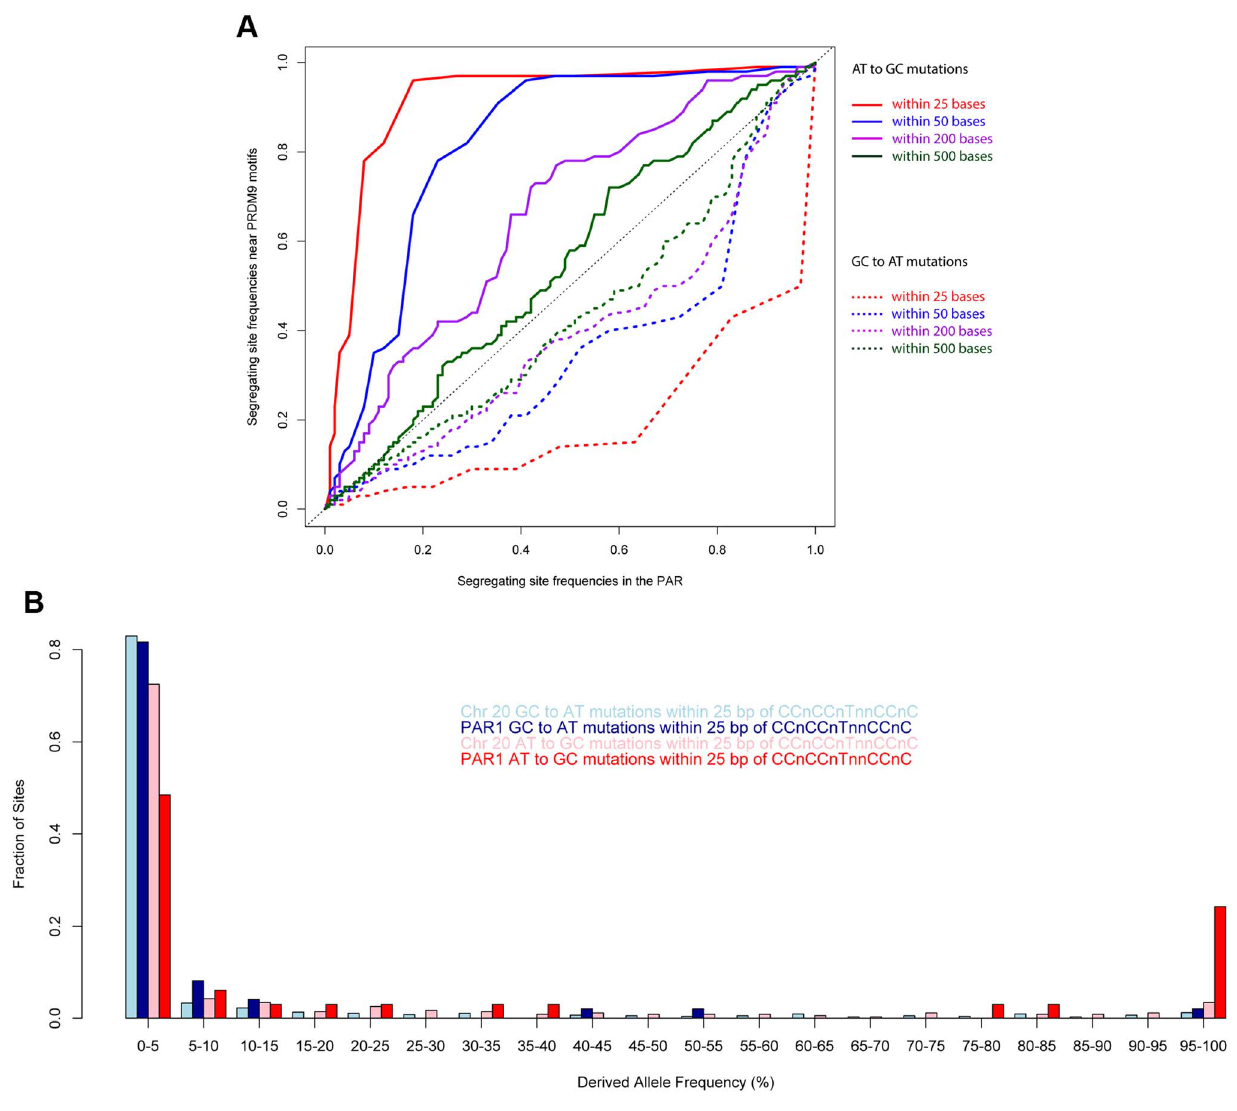
Figure 6. Allele frequencies near the PRDM9 binding motif show the strong influence of recombination. (A) Quantile-quantile plots comparing AT ? GC and GC ? AT allele frequencies in the vicinity of the motif CCnCCnTnnCCnC relative to the rest of PAR1 in human populations. The elevation of GC allele frequencies and suppression of AT alleles is extremely powerful closest to the motif, and drops off rapidly with distance away from it. (B) A comparison of the allele frequency spectra of different mutation types within 25 bp of copies of the motif CCnCCnTnnCCnC in PAR1 and Chr 20 shows an extreme skew towards GC bases in PAR1.